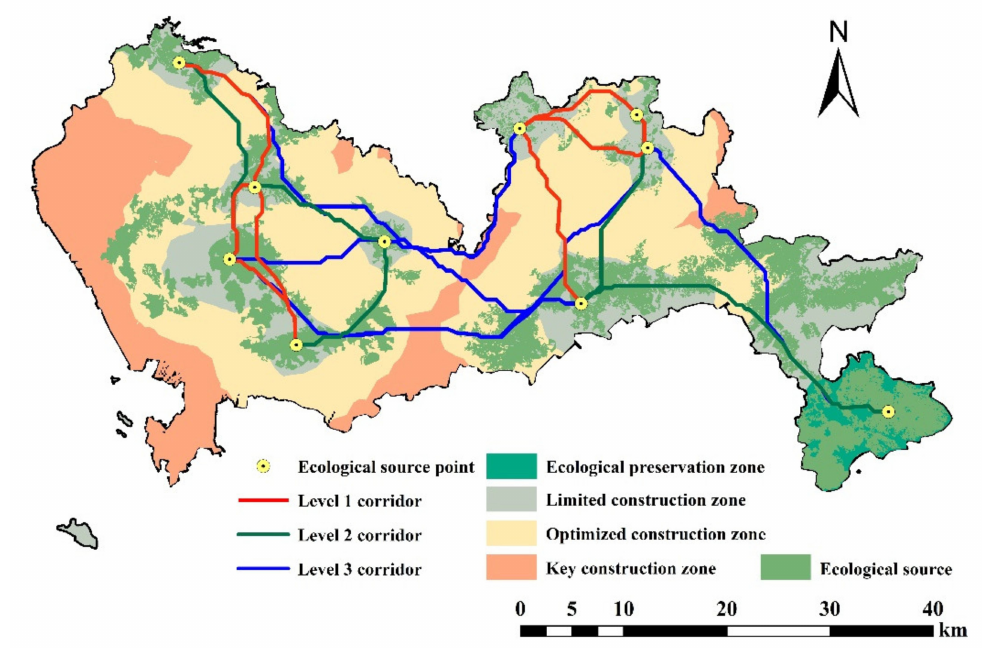
Figure 9. Distribution of ecological corridors in Shenzhen